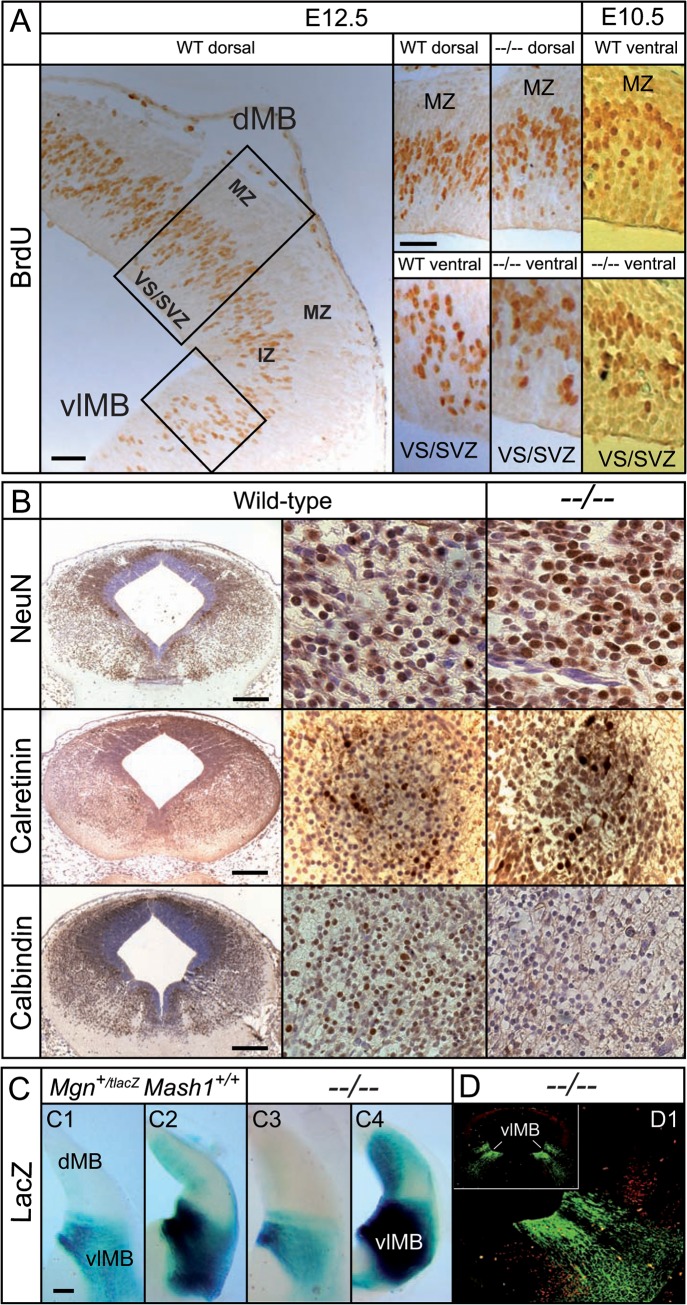
Depletion of dMB and vlMB GABAn in the Mgn
−/−
Mash
−/− mice occurred through GABAergic identity failure.
(A) Immunohistochemical staining of BrdU on coronal sections showing the distribution of BrdU+ cells in the developing dMB and vMB of wild-type (WT) and double mutant mice (−−/−−). (B) Neuronal cell density and cytoarchitectural analysis on the coronal sections of E12.5 embryos using NeuN and the Ca2+-binding proteins Calretinin and Calbindin, respectively. There were no significant difference between mean WT and double mutant (NeuN: dorsal WT = 64.22±2.08; dorsal −−/−− = 61.33±2.69; n = 18; p = 0.40. Medial WT = 52.28±3.60; medial −−/−− = 56.72±1.97; n = 18; p = 0.29. Ventrolateral WT = 46.44±2.36; ventrolateral −−/−− = 43.67±2.52; n = 18; p = 0.43); (Calbindin: dorsal WT = 43.28±6.20; dorsal −−/−− = 37.50±5.54; n = 18; p = 0.49. Medial WT = 52.22±5.32; medial −−/−− = 46.56±2.69; n = 18; p = 0.35. Ventrolateral WT = 47.39±3.19; ventrolateral −−/−− = 46.17±3.92; n = 18; p = 0.81). (C)
LacZ staining of coronal sections from double mutants and controls at E12.5; C2 and C4 show prolonged staining times. Owing to the long half-life of lacZ protein, signal can also be seen in the intermediate and mantle zones. (D) Immunohistochemical staining with anti-LacZ (in green) and anti-BRN3a (Pou4f1_MGI) (in red, as a morphological marker) antibodies that shows radial migration of GABA-defective neurons through the intermediate zone (IZ) toward the mantle zone (MZ) in double mutants. Scale bars: 100 μm in A, and 200 μm in B-C.